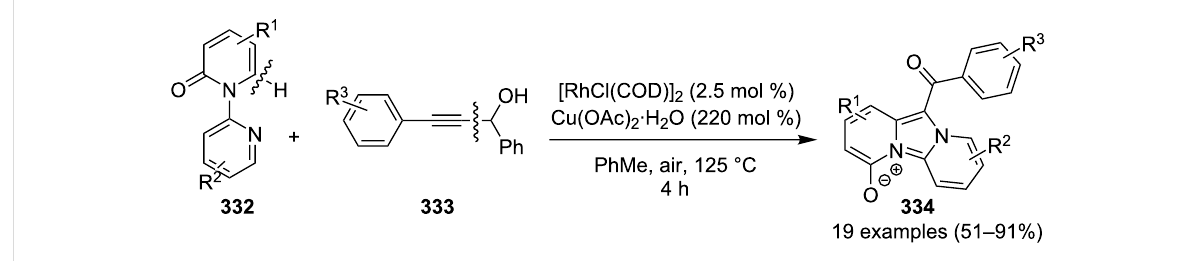
Scheme 109: Reactivity and selectivity of different substrates.